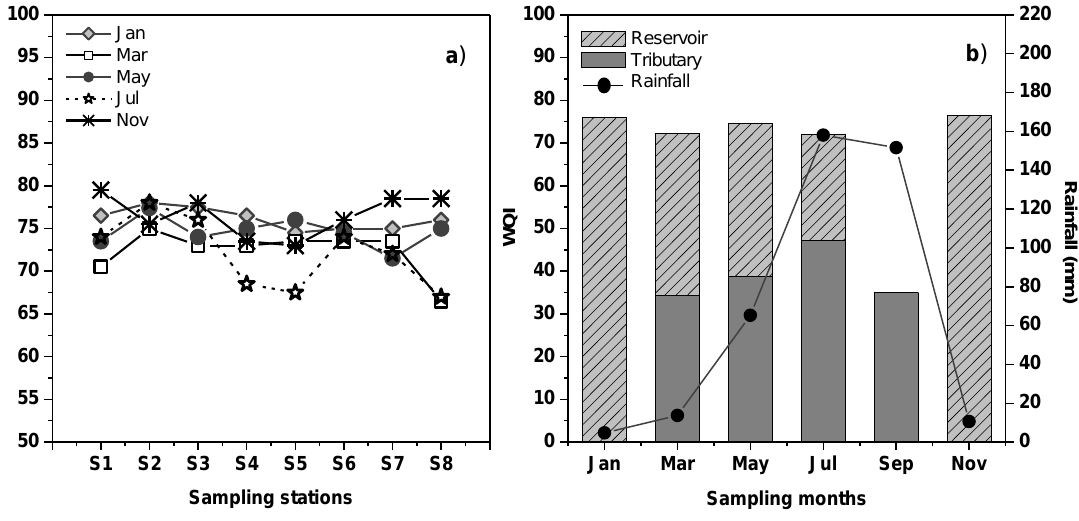
Figure 4. ( a ) Water quality index (WQI) obtained for sampling stations of the reservoir. ( b ) Tributary and reservoir